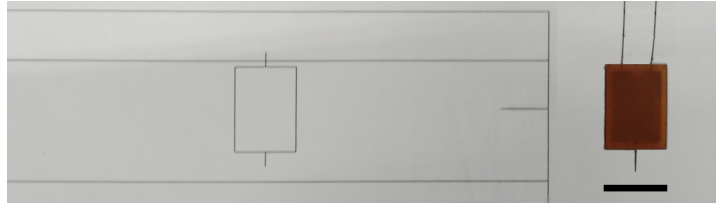
Figure 5. The application self-adhesive foil for precise placement of strain gauges—drawing of the foil and strain gauge applied on the foil.